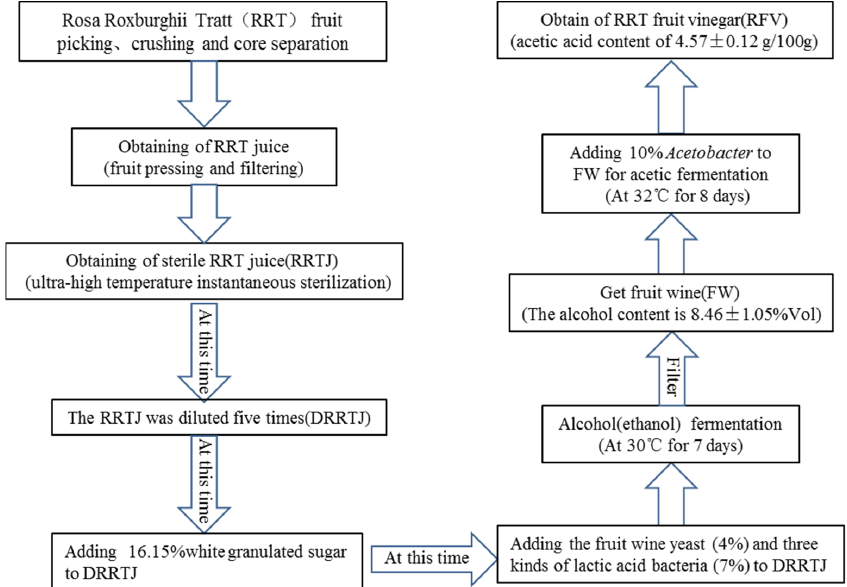
Figure 1. Production process of Rosa roxburghii Tratt fruit vinegar. All starter concentrations reached 10 8 log CFU mL − 1 in juices. Values are displayed as a bar chart plot with means (expressed as ‘+’), n = 3.